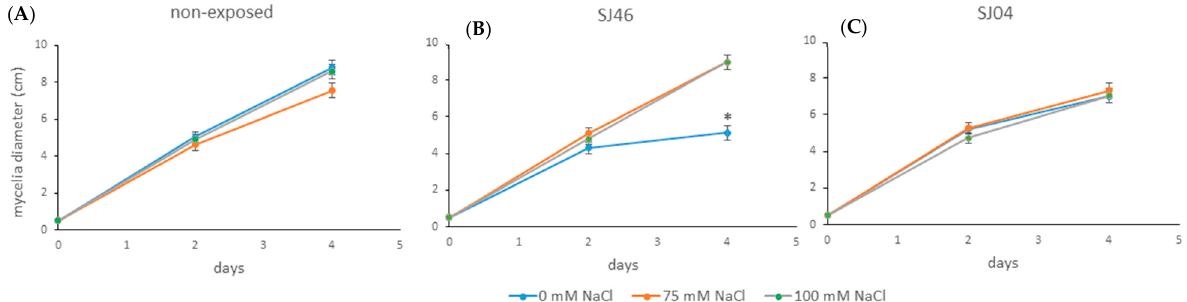
Figure 5. ( A ) Effect of the mVOCs of two PGPR, P. putida SJ46 and SJ04, grown under salt stress conditions (0 mM, 75 mM and 100 mM) on the growth of Sclerotium rolfsii on the fourth day of the challenge. ( B ) Photos of S. rolfsii cultures exposed to different treatments. Different letters indicate statistically significant differences. Fisher’s LSD test ( p < 0.05). The VOCs emi tt ed by SJ46 and SJ04 under salt concentrations had di ff erent e ff ects on the growth of S. rolfsii during the 4 days of the assay (Figure 6). Under 0, 75 and 100 mM, the VOC emissions of non-bacterial and SJ04 did not modify the growth of S. rolfsii on days 2 or 4 ( p > 0.05) (Figure 6A,C). However, the VOCs emi tt ed by SJ46 under salt stress (75 or 100 mM) increased the mycelium growth of S. rolfsii , but this was only observed on the fourth day ( p < 0.05) (Figure 6B).